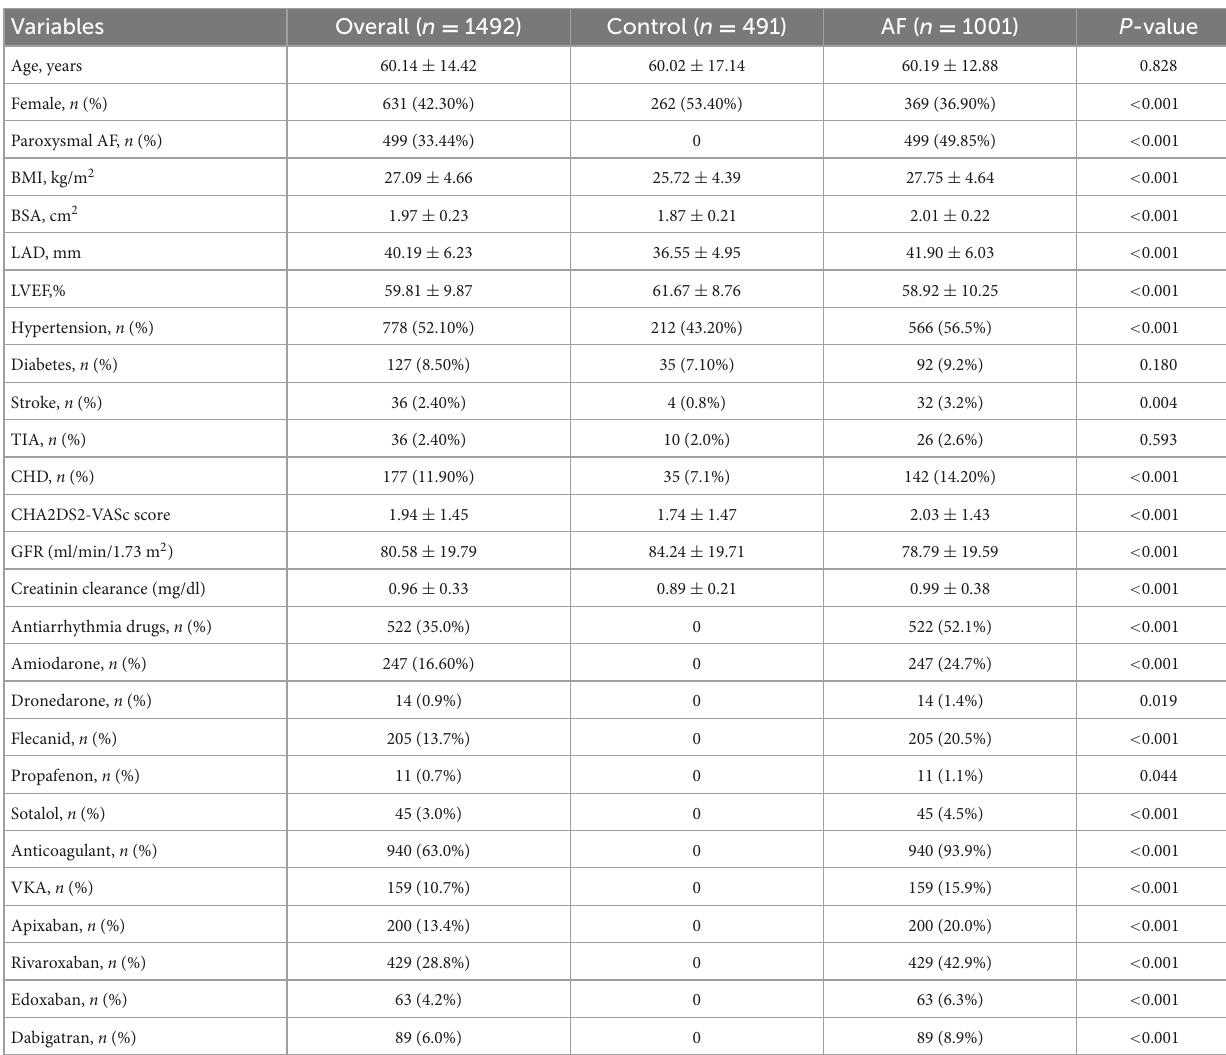
TABLE 1 Baseline characteristics of total